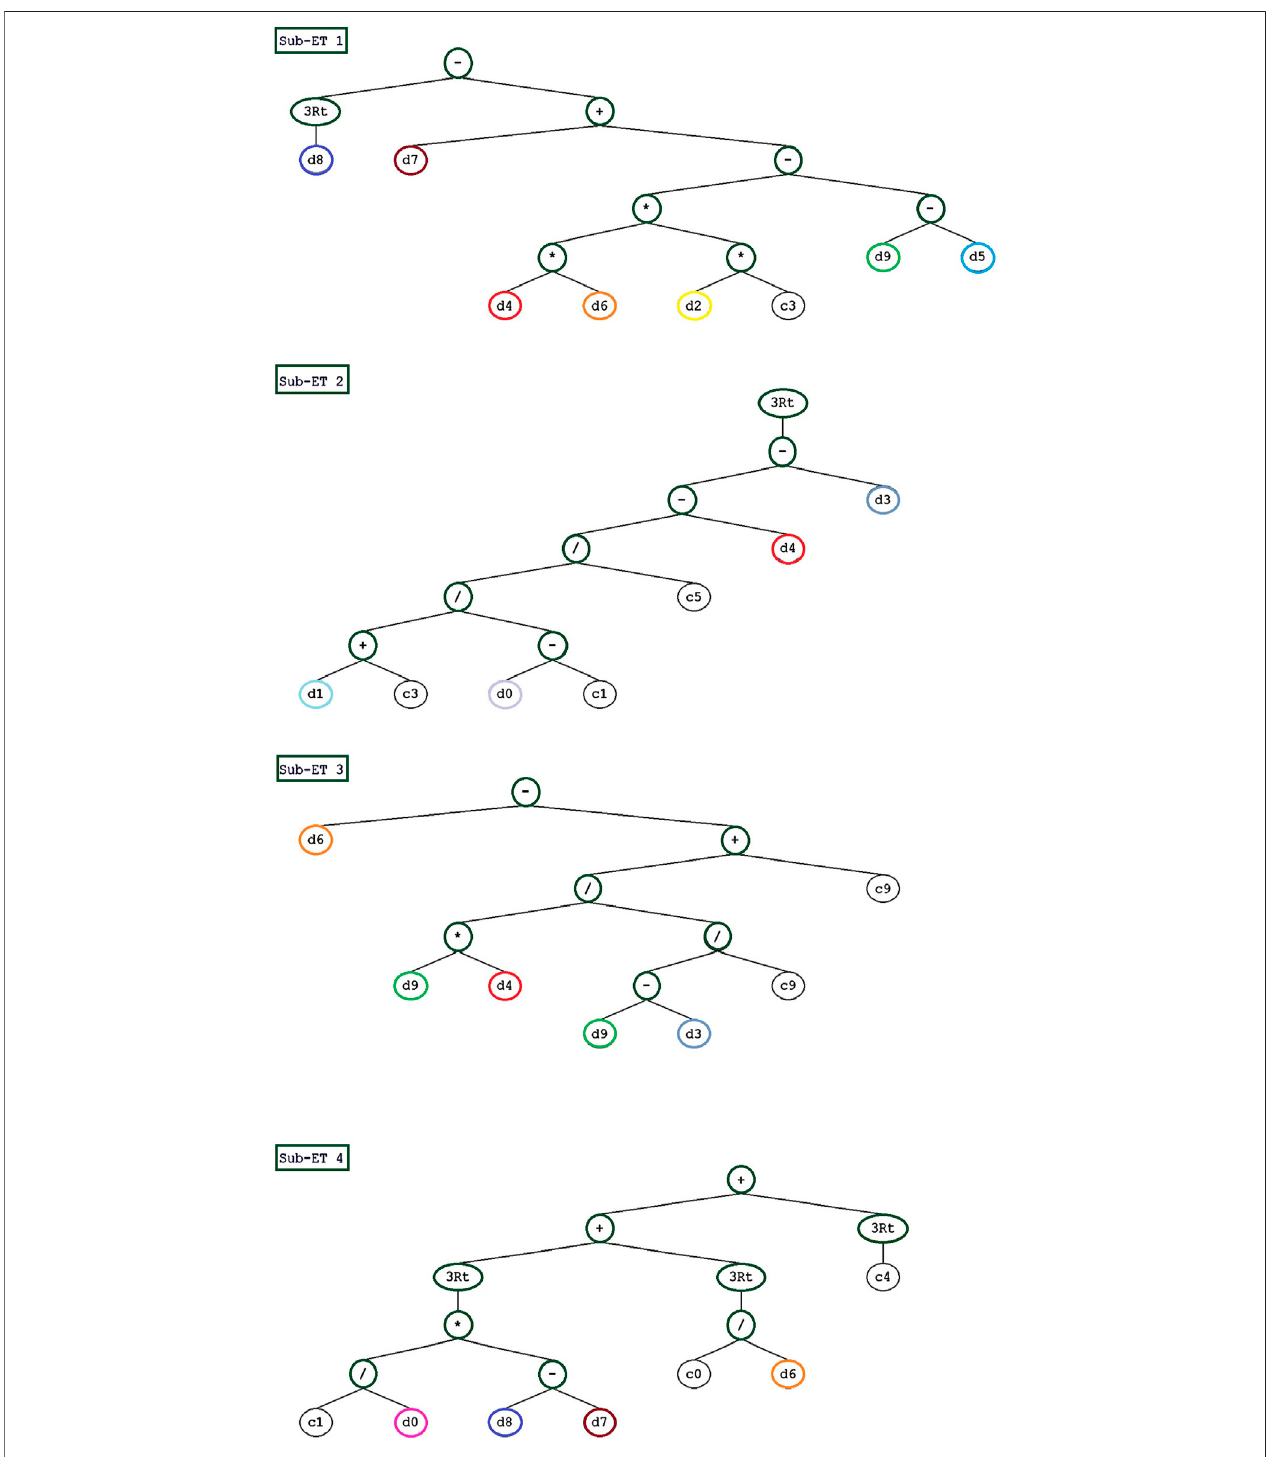
FIGURE 7 | Expression trees (ETs) of the GEP